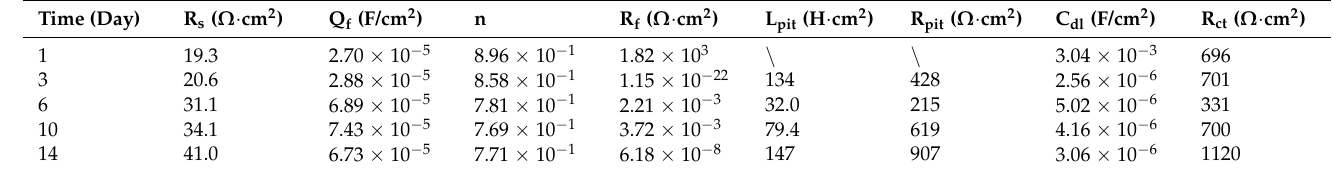
Figure 9. Equivalent circuit used to fit the EIS data in Figure 8. ( a ) d1; ( b ) d3 − d14. Table 3. Fitted electrochemical parameters for AZ31B magnesium alloy after immersion in abiotic mudflat. Table 2. Fitted electrochemical parameters for AZ31B magnesium alloy after immersion in biotic mudflat.